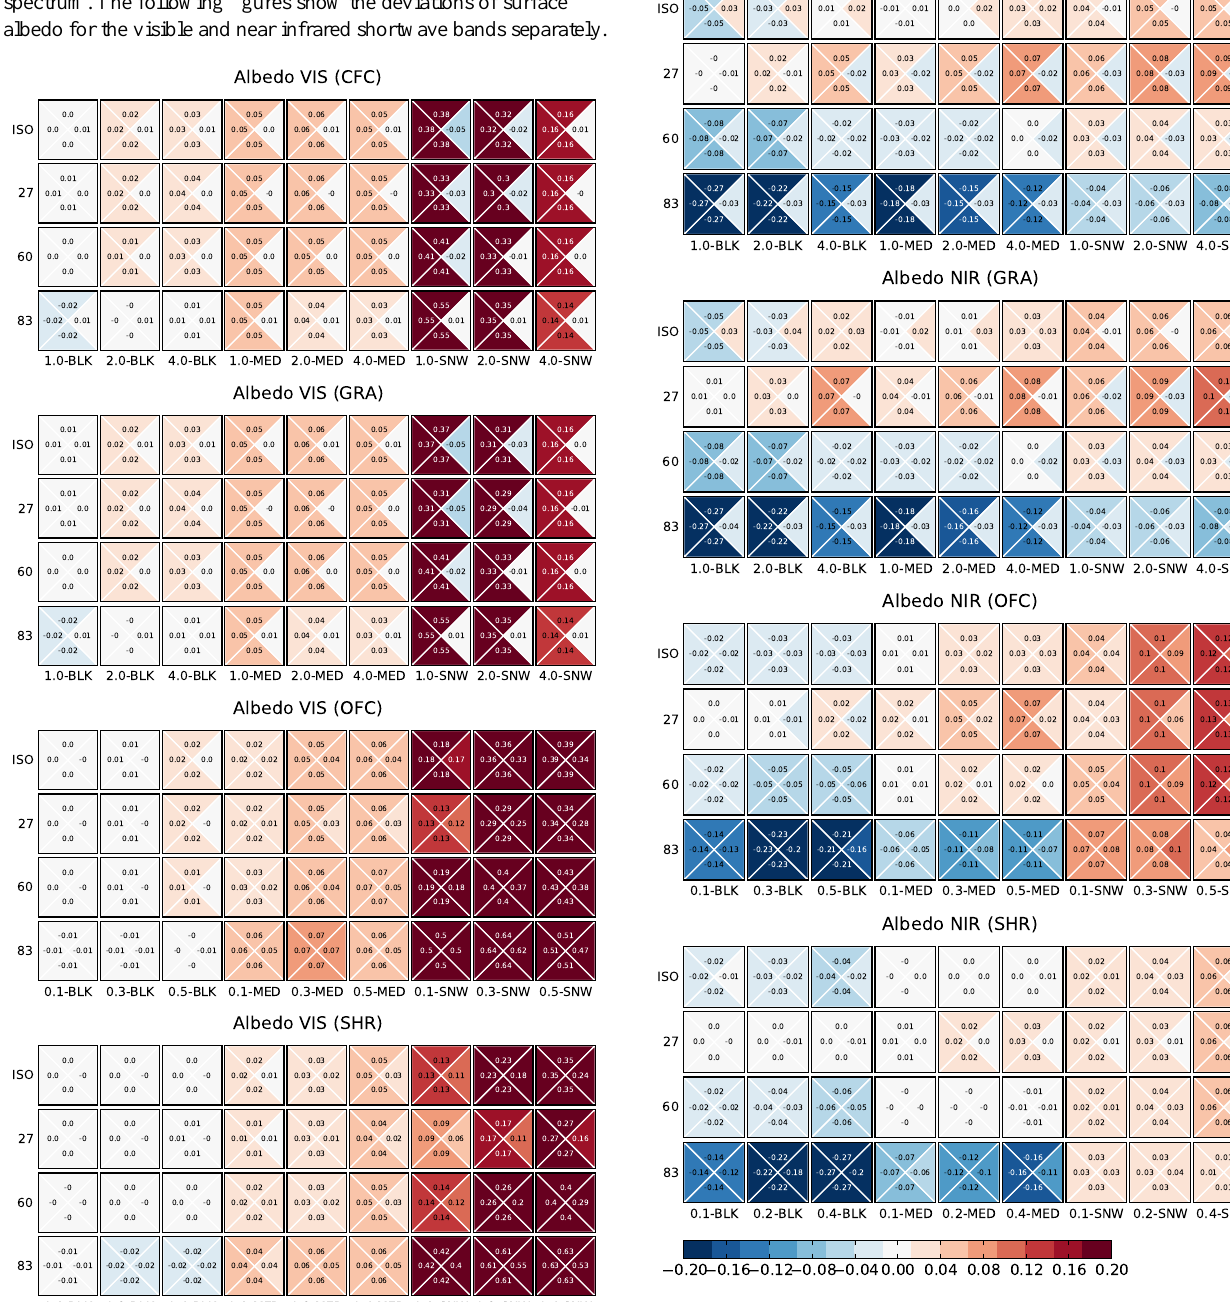
Fig. A2. Deviations of simulated surface albedo from RAMI4PILPS reference solutions ( α model − α ref ) for the NIR spectrum (0 . 7 to 3 . 0 µm ). Details of figure structure are the same as Figure 3 Fig. A1. Deviations of simulated surface albedo from RAMI4PILPS reference solutions ( α model − α ref ) for the VIS spectrum (0 . 3 to 0 . 7 µm ). Details of figure structure are the same as Fig. 3.